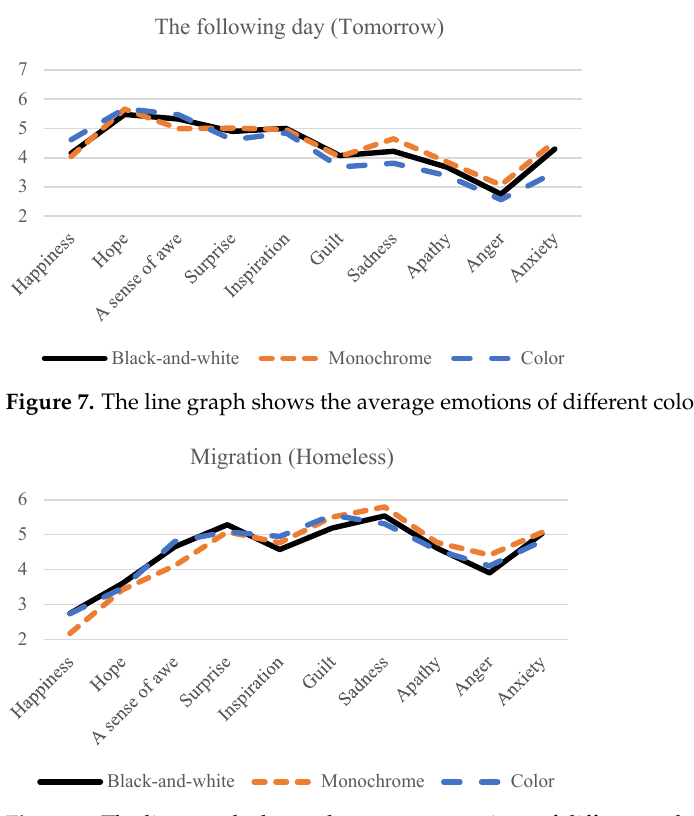
Figure 6. The line graph shows the average emotions of different colors in #1 image.